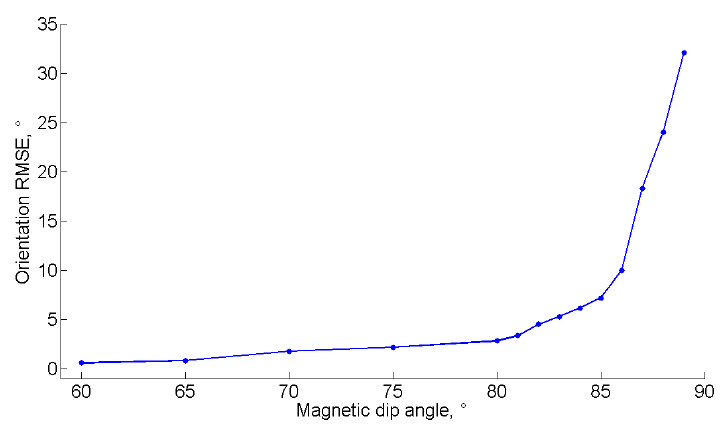
Figure 2. Orientation RMSE vs. magnetic dip angle.